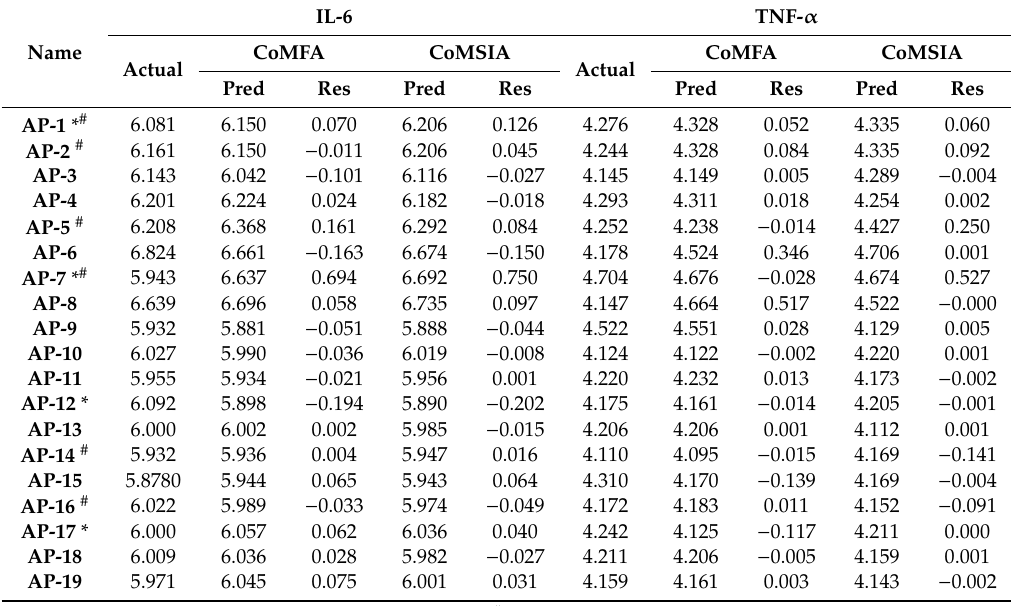
Table 4. The actual pI, predicted pI and their residuals of the training and test set molecules. IL-6 TNF- α